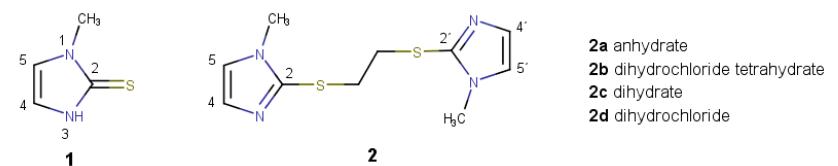
Figure 1. Methimazole ( 1 ) and 1,2-bis[(1-methyl-1 H -imidazole-2-yl)thio]ethane ( 2 ) in different forms ( 2a – 2d ).